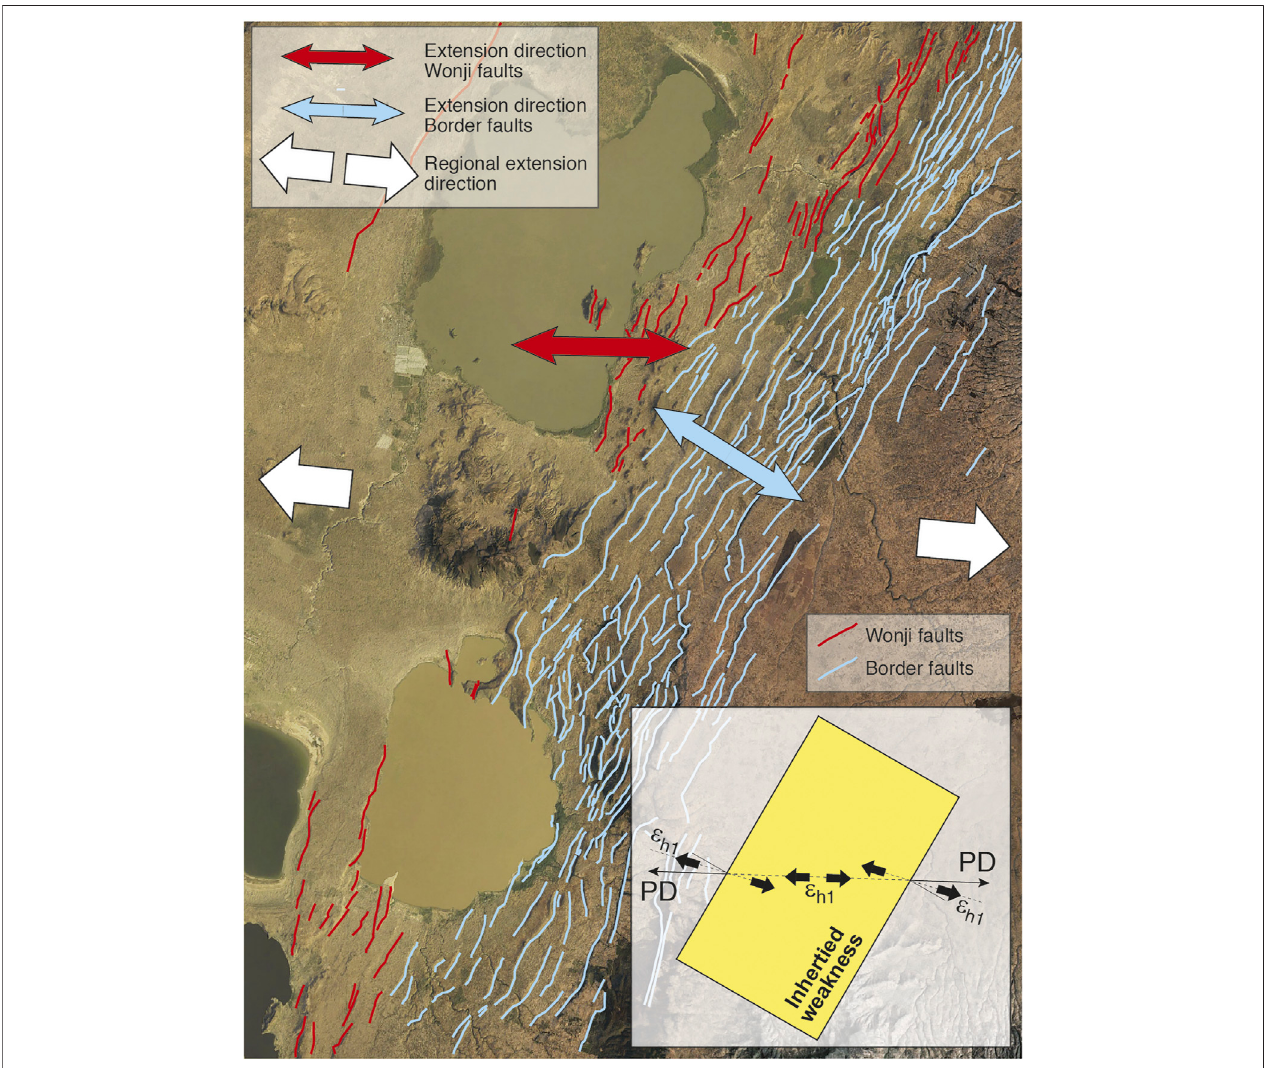
FIGURE 6 | Reorientation of the extension direction at the Asela-Langano margin. The local direction of extension at boundary and internal faults is indicated with lightblue and redarrows,respectively; theregionaldirectionofextension isillustrated with thebigwhitearrows. Insetinthe bottomright shows therelationshipbetween the rift trend (or its perpendicular), the regional direction of extension (or plate divergence, PD) and the trend of the greatest horizontal principal strain ( ε h 1 ) in the different portions of the oblique rift (modi fi ed from Corti et al., 2020).